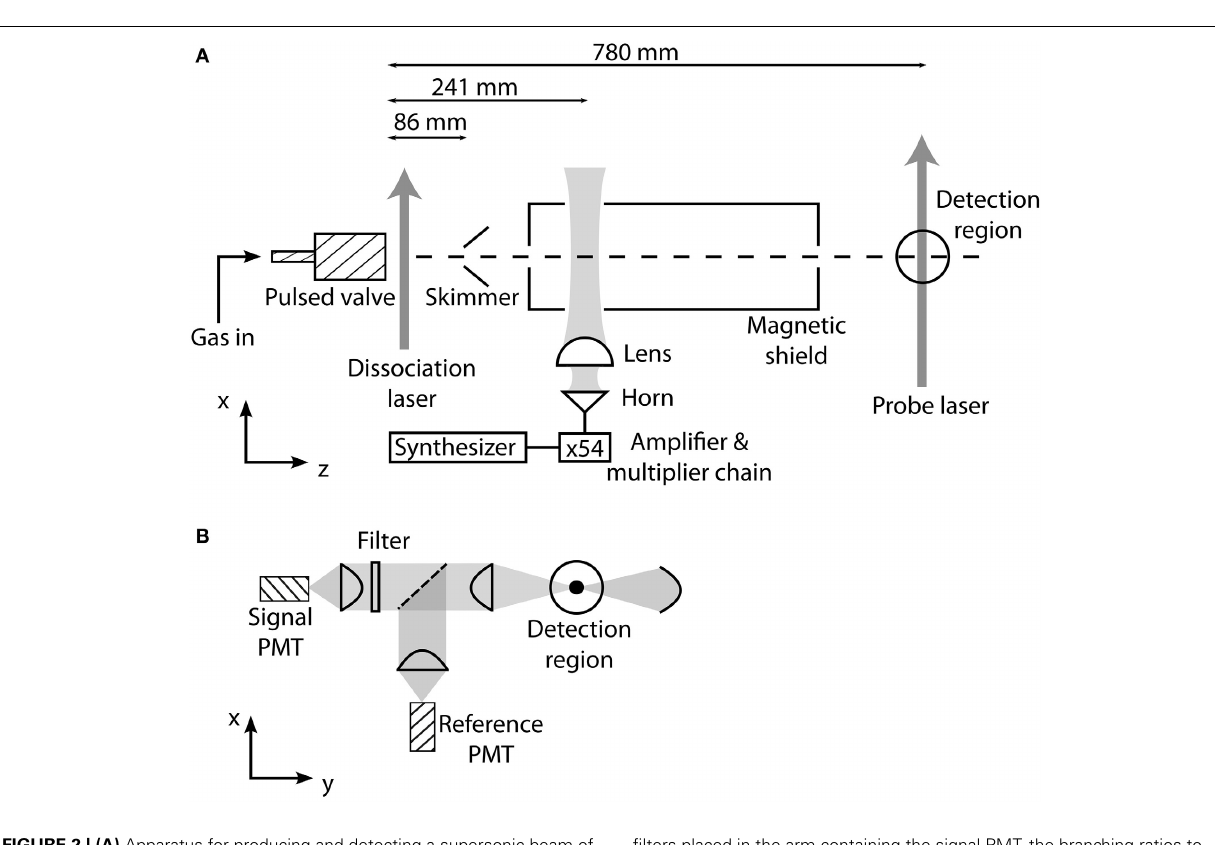
FIGURE 2 | (A) Apparatus for producing and detecting a supersonic beam of BH molecules, and for driving transitions between rotational states. (B) Laser-induced fluorescence detection setup. Using a set of interference